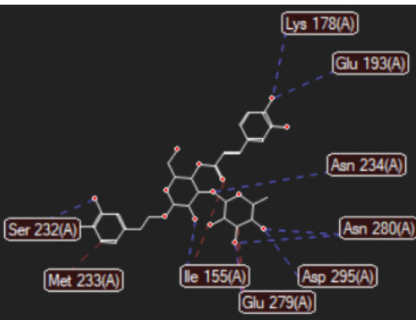
Figure 3. The hydrogen bonds (blue) and steric interactions (red) between the verbascoside ligand and the active amino acids residues of the binding site of 5ZTN in 2D